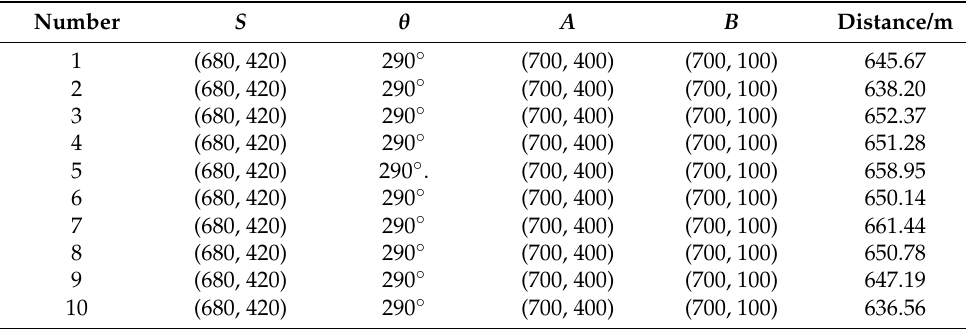
Table 5. Repeated experiments in the super near point